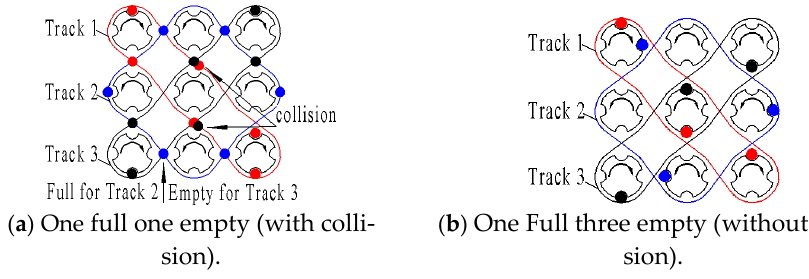
Figure 1. Carrier arrangements in a three ‐ track square machine.